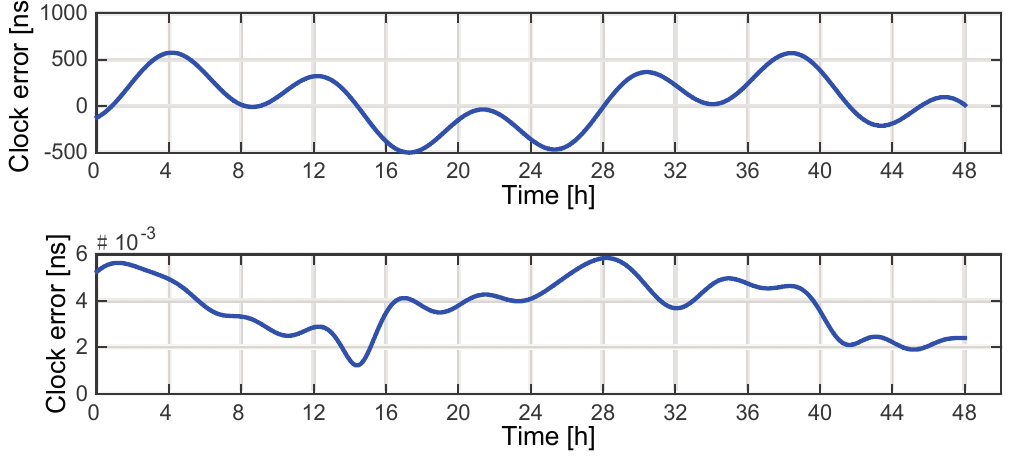
Figure 9. Decoupling clock error of Beidou A2 before (up) and after (down) motion